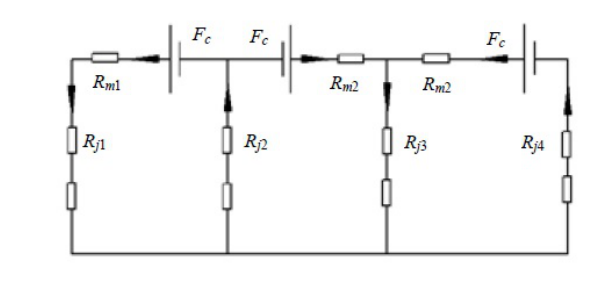
Fig. 5 Equivalent magnetic circuit diagram of split pole boot structure after